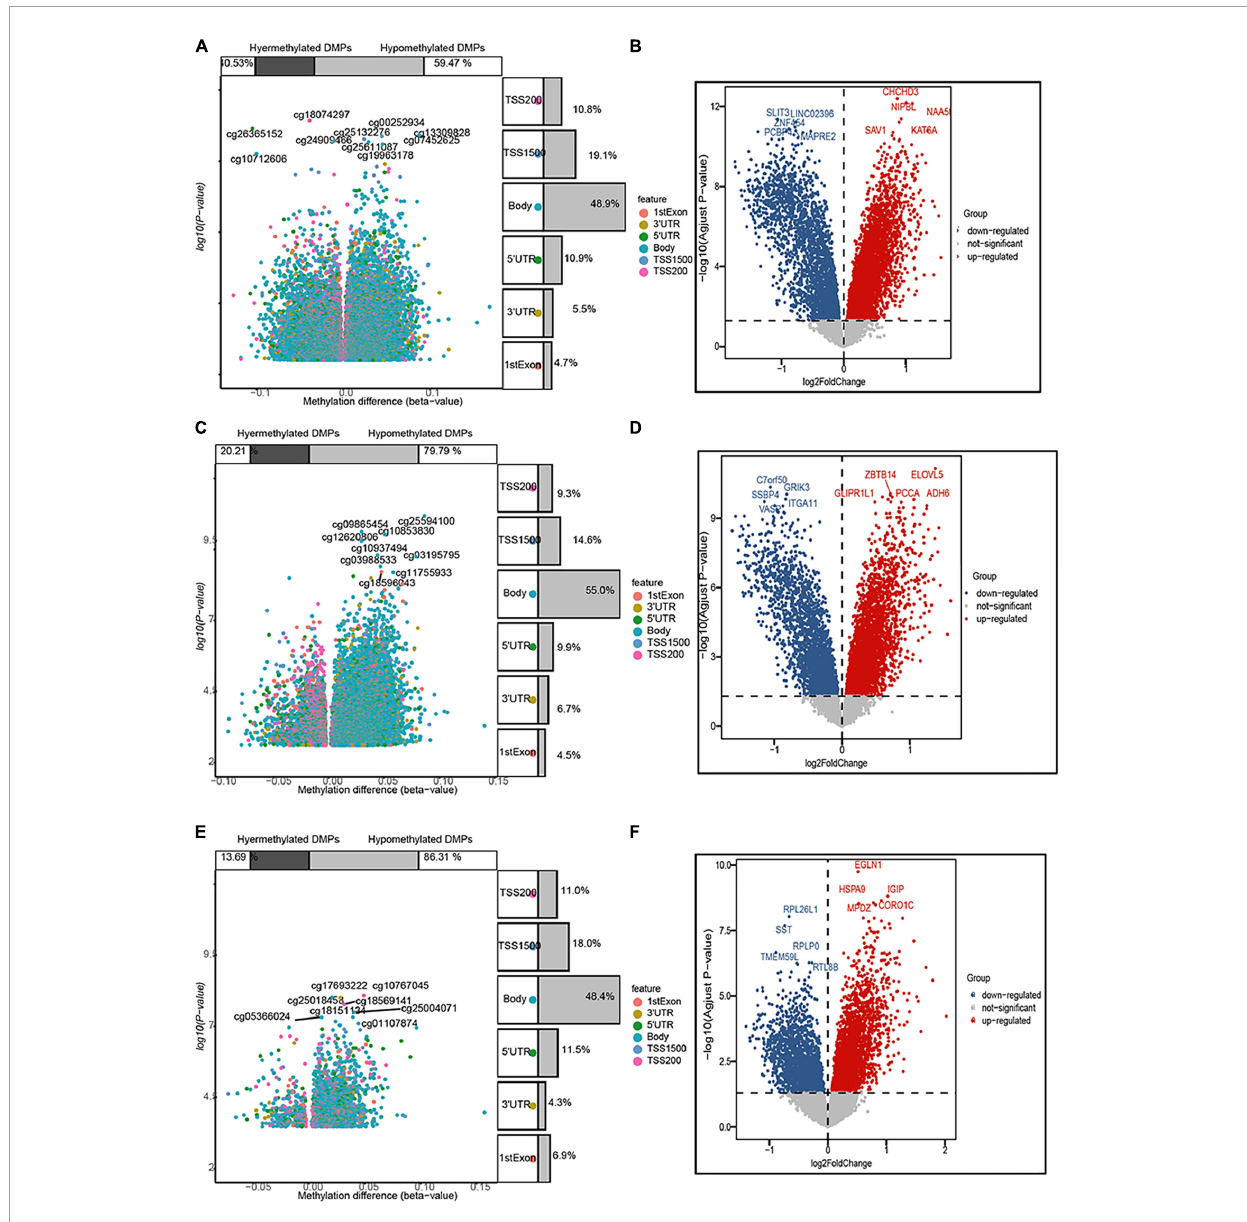
FIGURE2 Volcano map of 5’-cytosine–phosphate–guanine-3’ (CpG) sites and differentially expressed genes (DEGs) after filtering. The three panels show the distribution characteristics of differentially methylated CpG sites and differentially expressed genes, respectively, in the (A,B) entorhinal cortex, (C,D) prefrontal cortex, and (E,F) superior temporal gyrus, as well as the ratio of hypermethylated to hypomethylated CpG